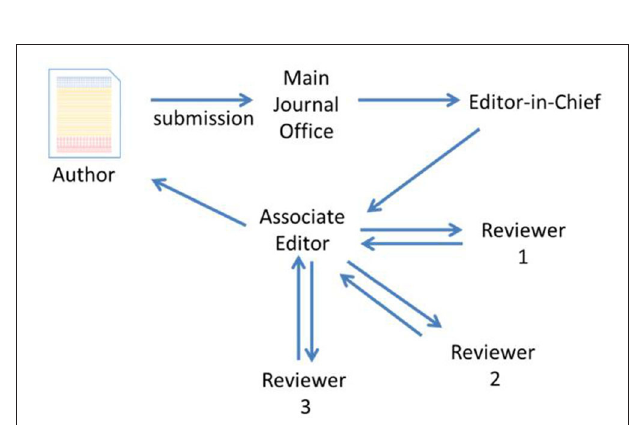
FIGURE 3 | Editorial process at ACS journals (adapted from the presentation of E. Carreira, ACS on Campus at ETH Zürich, July 9,